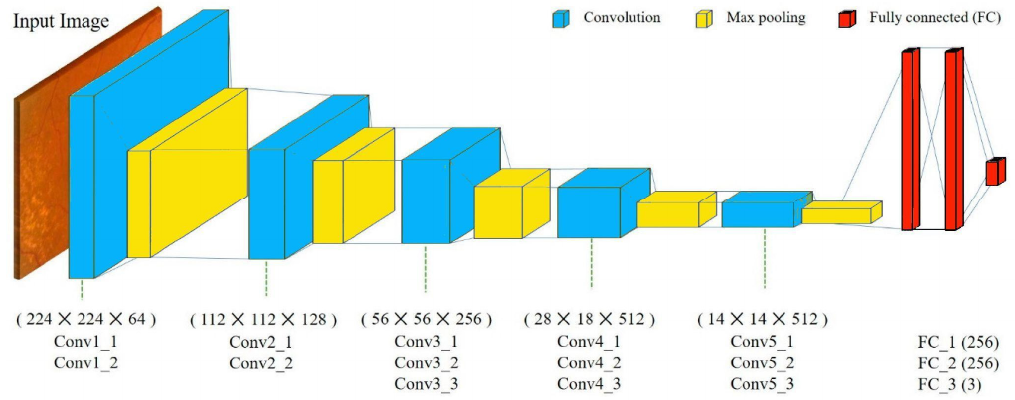
Figure 13. VGG-16 CNN model architecture.